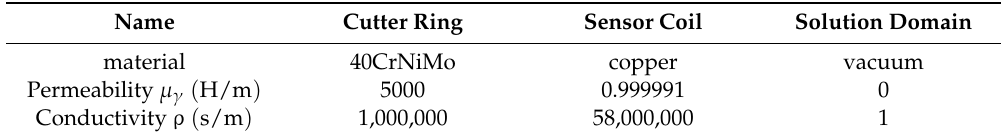
Figure 5. Characteristic curve of inductance displacement.